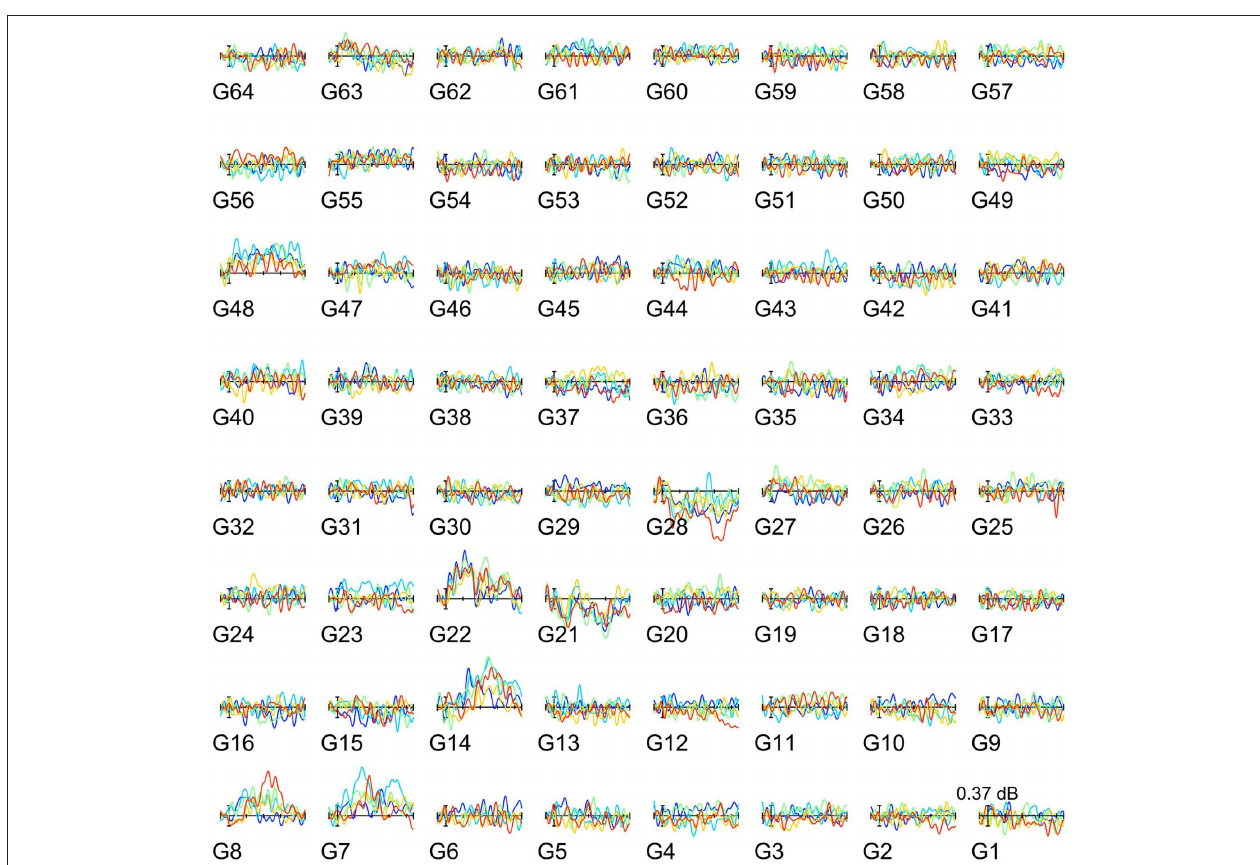
Figure A2 | High-gamma-power waveforms. High-gamma (70–190 Hz) power waveforms for the same subject as in Figure 4 . The legend is as in Figure 4 except for ordinate units, which are now in dB with respect to the pre-stimulus